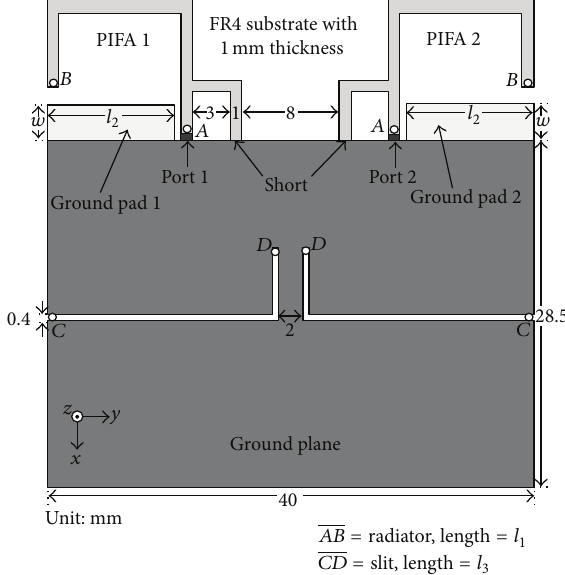
Figure 1: Geometry of the proposed antenna.